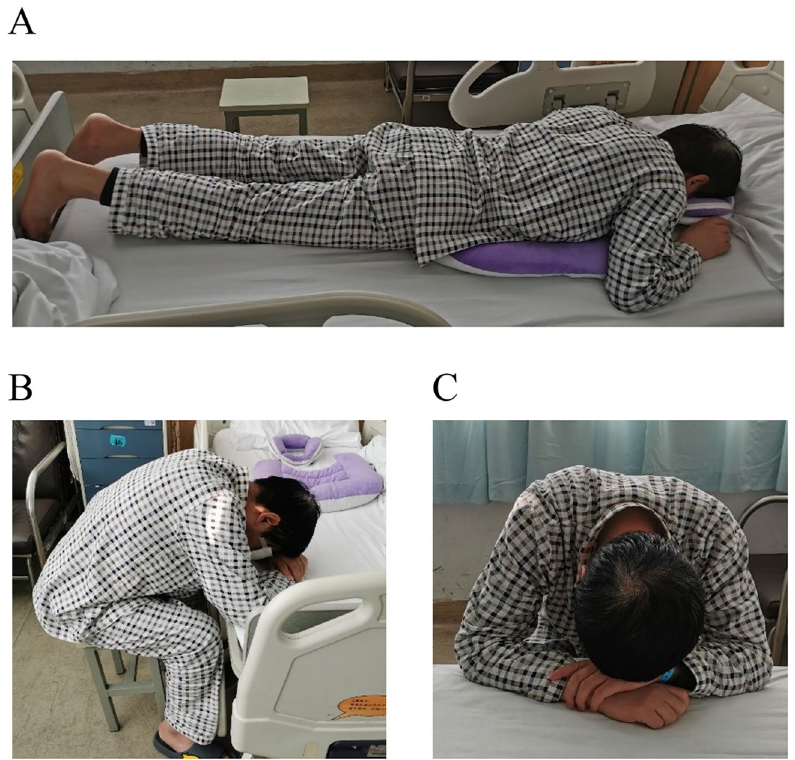
Figure 2. Patient’s face down position. ( A ) shows the patient’s prone position. ( B , C ) shows the front and side of the patient’s sitting